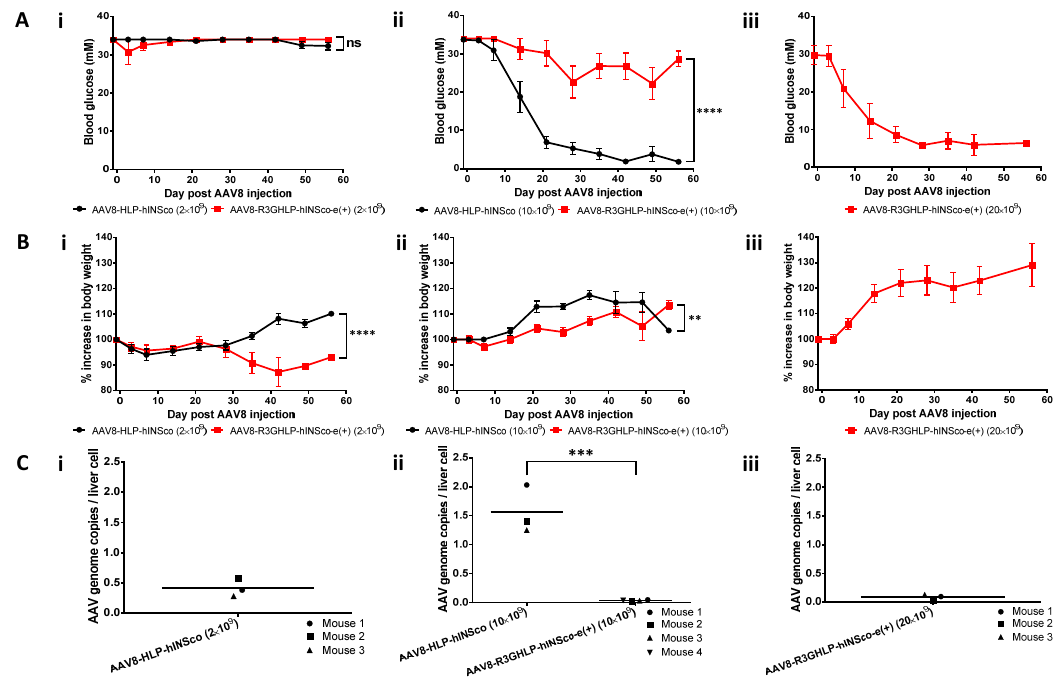
Figure 6. Treatment e ffi cacy of AAV8-R3GHLP-hINSco-e( + ) on STZ-induced diabetic NSG mice. Treatment e ffi cacy of control non-glucose responsive AAV8 vector, AAV8-HLP-hINSco and glucose responsive AAV8 vector with 3 (cid:48) iALB enhancer, AAV8-R3GHLP-hINSco-e( + ) at various doses at ( i ) 2 × 10 9 , ( ii ) 10 × 10 9 and ( iii ) 20 × 10 9 (AAV8-R3GHLP-hINSco-e( + ) only) vg /